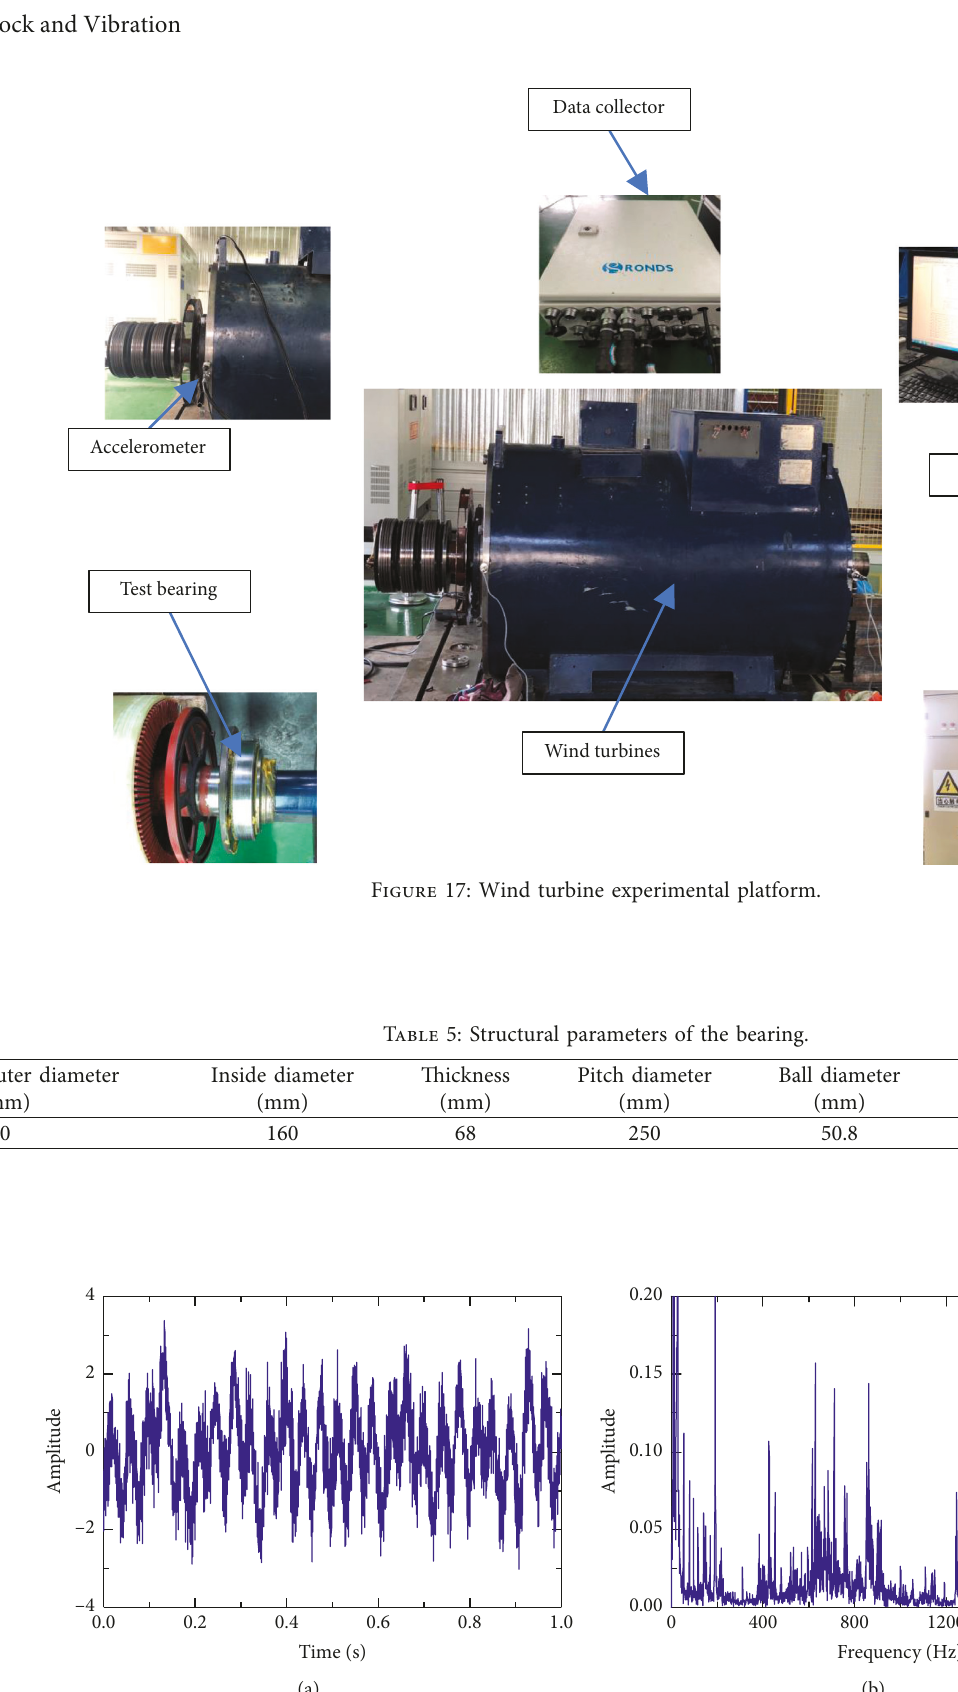
Figure 18: Waveform and amplitude spectrum of the outer race defect signal: (a) time-domain waveform; (b) amplitude